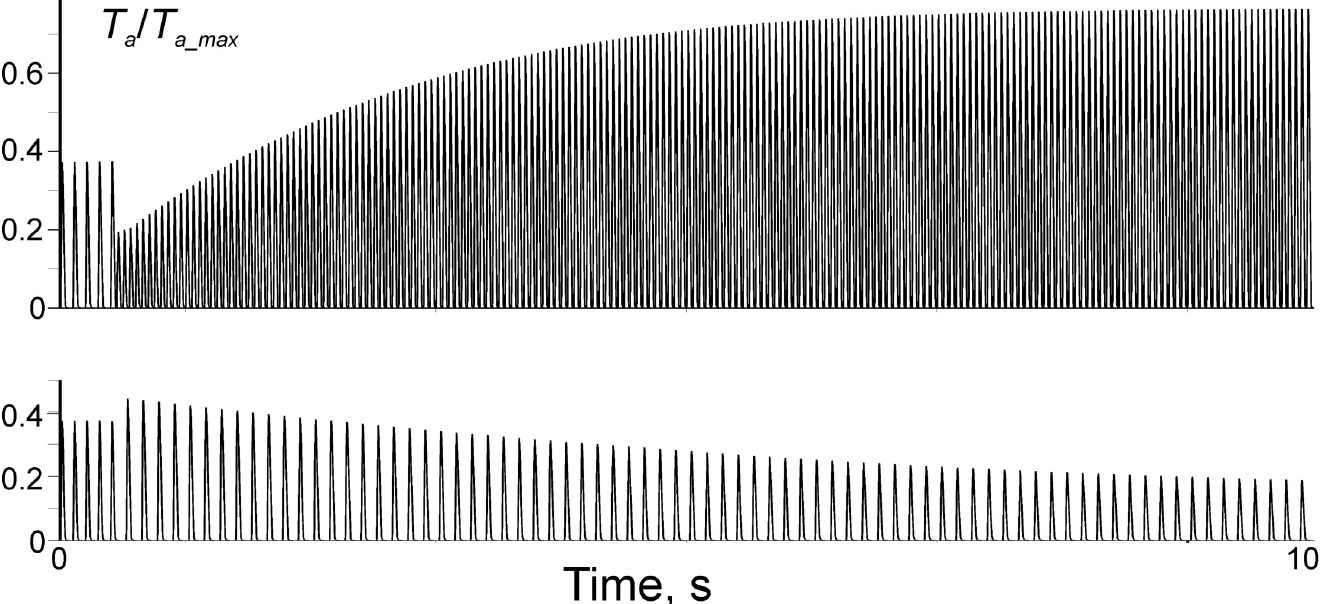
Fig 4. Changes in twitch amplitude (normalised active tension) upon changes of stimulation frequency. The stimulation frequency changed from 1 Hz to 2 Hz (upper trace) and from 1 Hz to 0.8 Hz (lower trace).